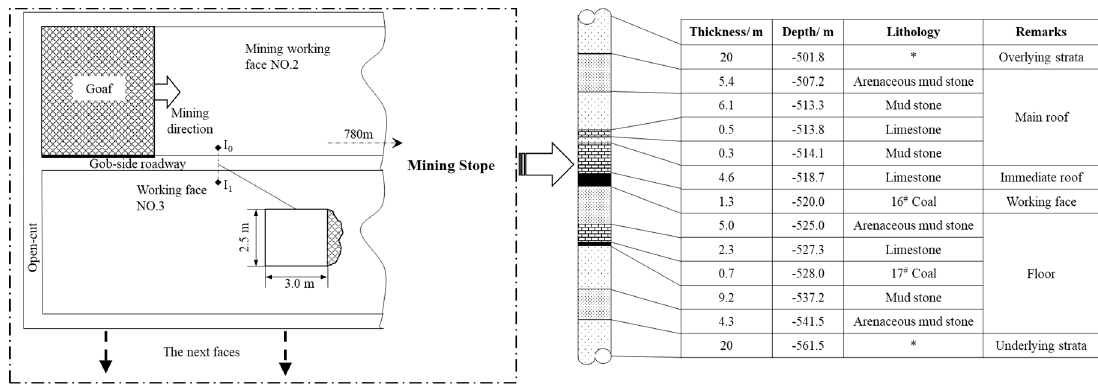
Figure 3. Mining stope and generalized stratigraphic diagrammatic sketch.